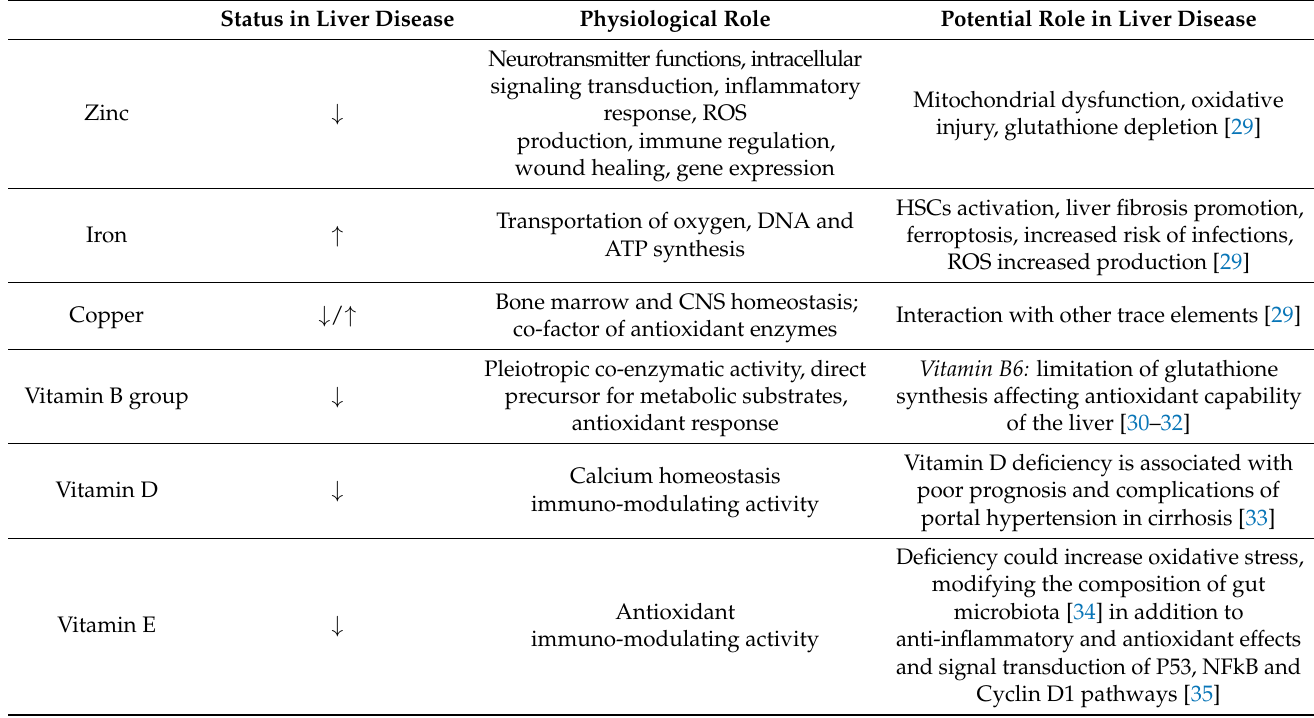
Table 1. Trace elements and vitamins imbalance in